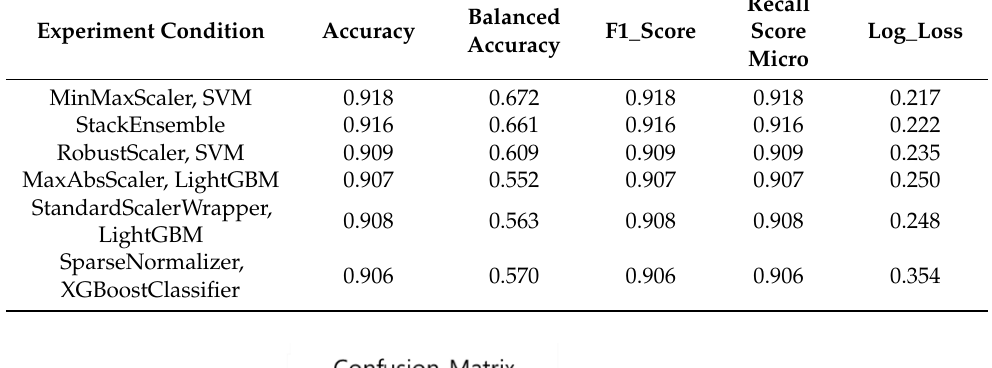
Table 1. Etching environment algorithm performance evaluation.